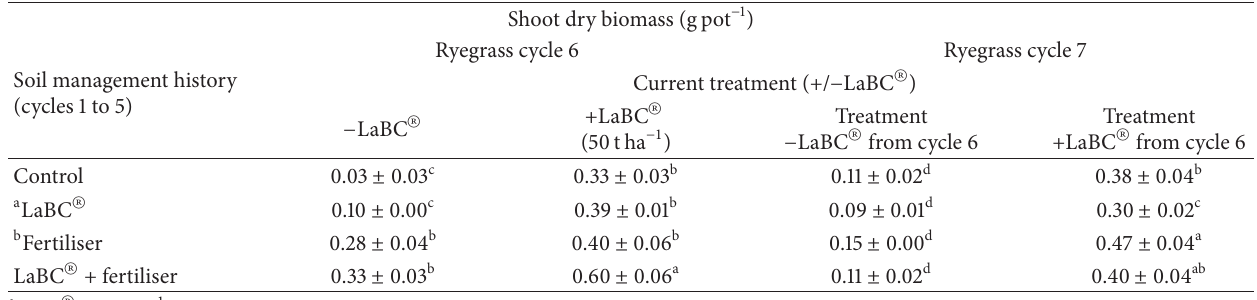
Table 3: Shoot dry biomass (g pot − 1 ) in ryegrass cycles 6 and 7 with reapplied LaBC Ⓡ (+/ − ) as influenced by residual effects of soil amendments from previous management